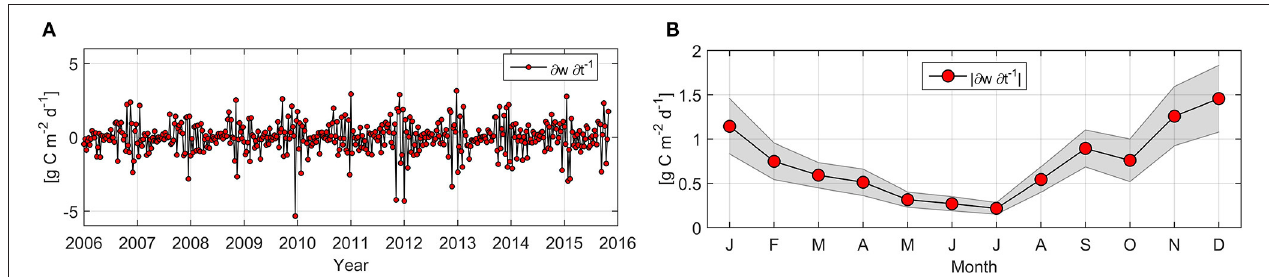
FIGURE 9 | Temporal evolution (A) and absolute climatology mean (B) for Net Primary Production week-to-week variability. Shaded area represents a 95% confidence interval.